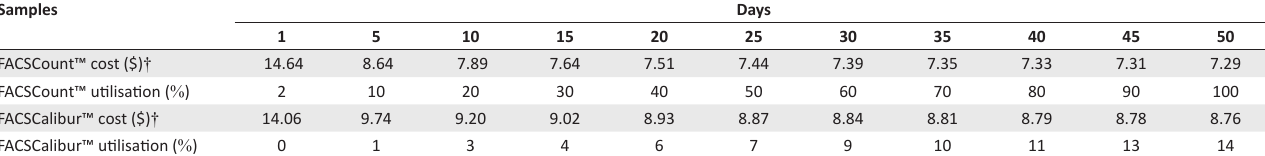
TABLE 2: FACSCount™ and FACSCalibur™ reagent unit price per test. Samples